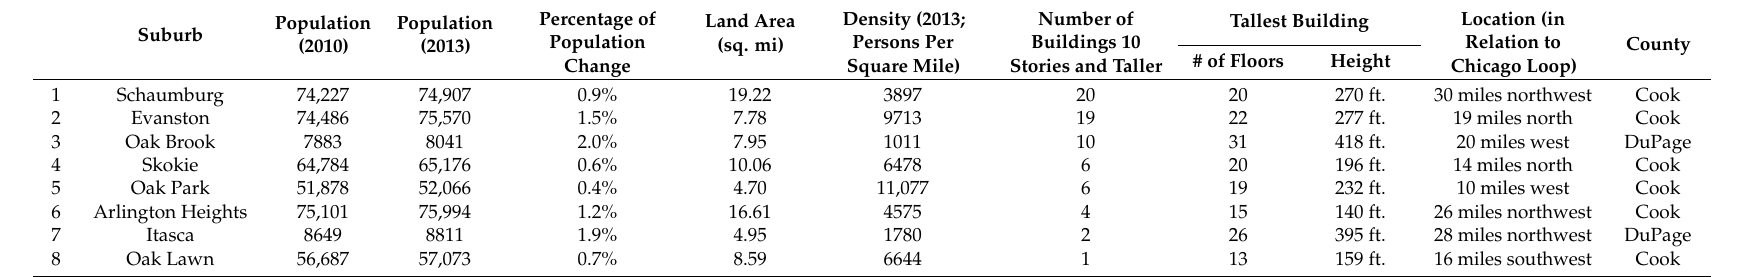
Table 6. Summary of the spatial profile of the examined suburban communities in the Chicago region